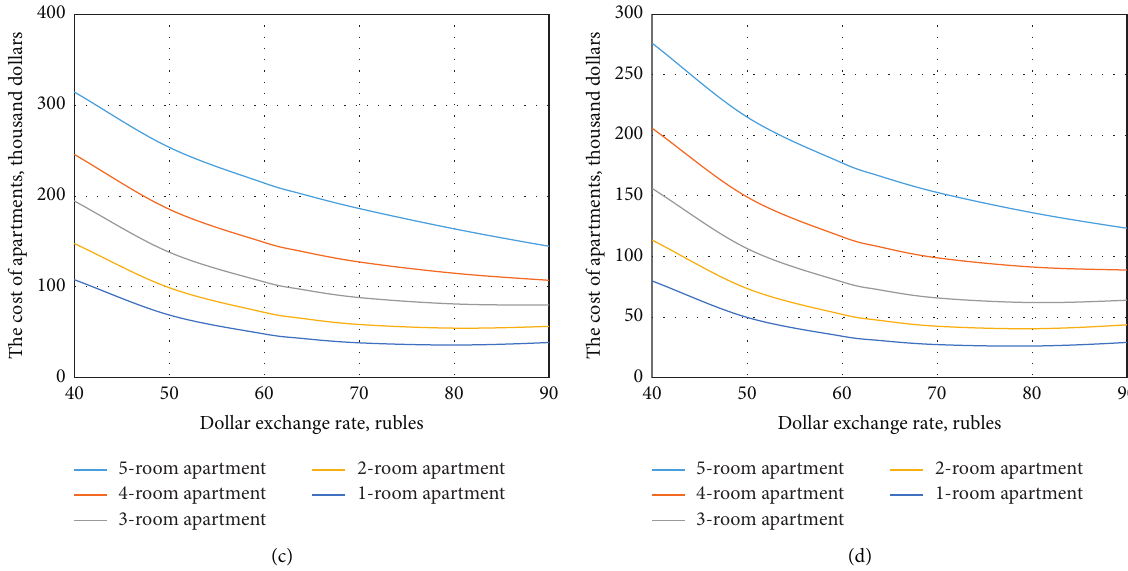
Figure 11: Scenario forecast of the dependence of apartment costs expressed in US dollars on the exchange rate of the US dollar against the Russian ruble. (a) Moscow, (b) Saint Petersburg, (c) Yekaterinburg, and (d)